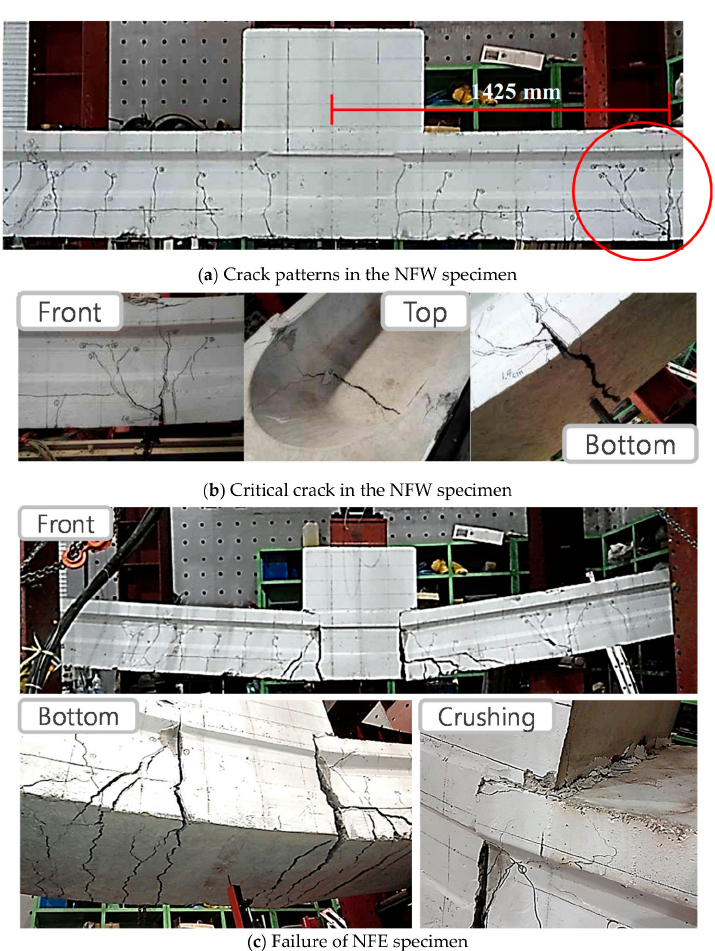
Figure 13. Failure crack patterns of the NFW and NFE